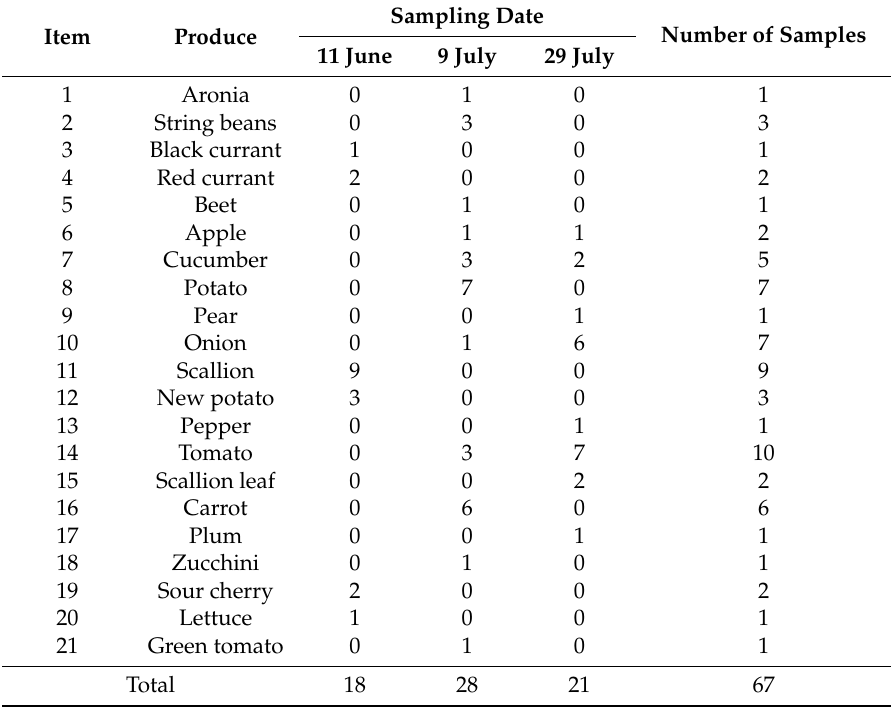
Table 3. Sampling dates and number of produce samples collected in village Baroševac during 2015.